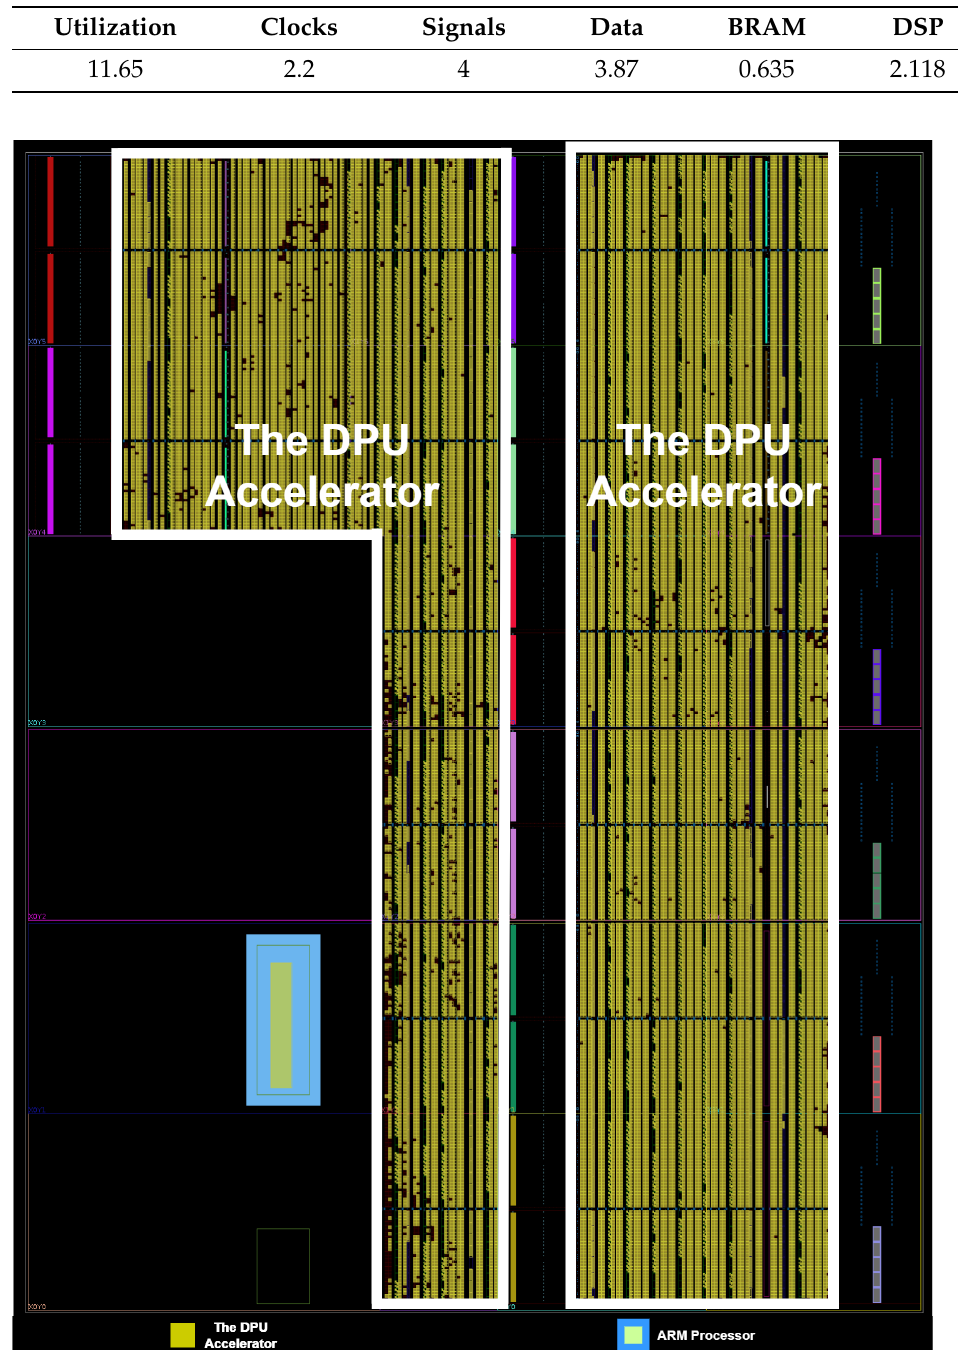
Figure 9. FPGA floorplan of the DPU